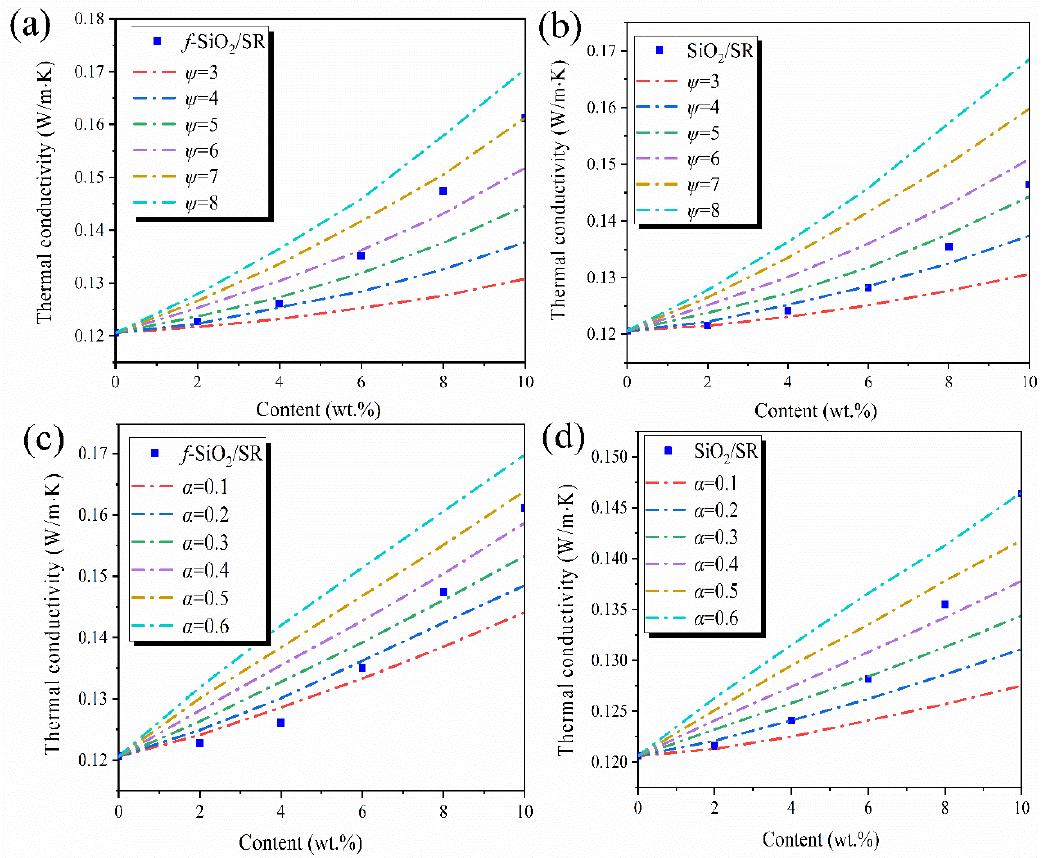
Figure 9. ( a , b ) The effect of filler shapes on thermal conductivity of composites and ( c , d ) the effect of interfacial thermal resistance on thermal conductivity of composites.